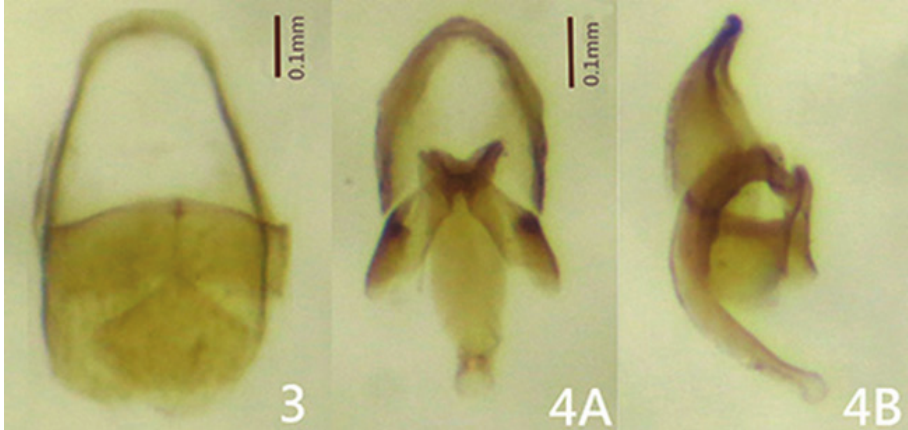
Figures 3–4. Oculogryphus chenghoiyanae sp. n., male. 3 aedeagal sheath, dorsal aspect 4 aedeagus, dorsal ( A ) and lateral ( B )